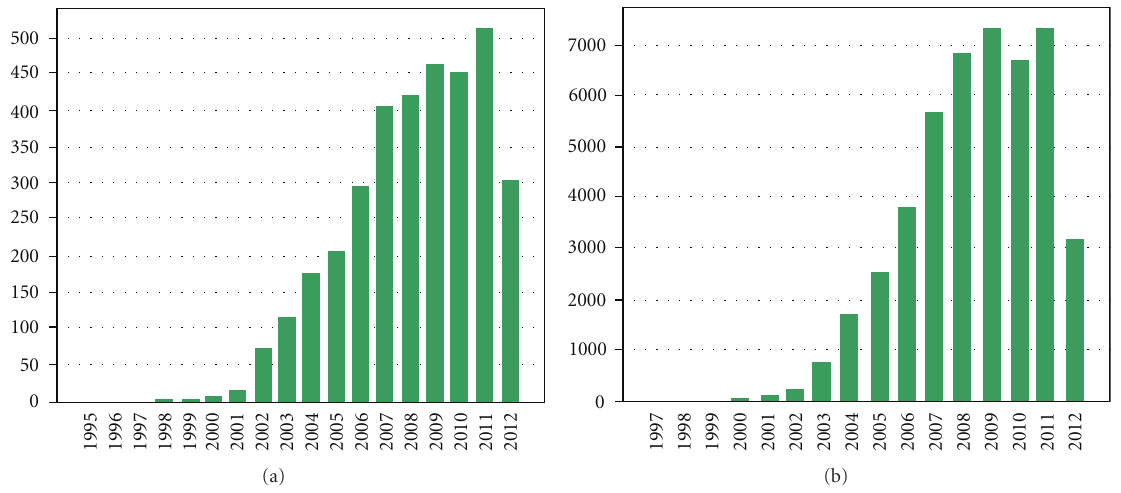
Figure 1: (a) Paper number published per year. (b) Paper citation per